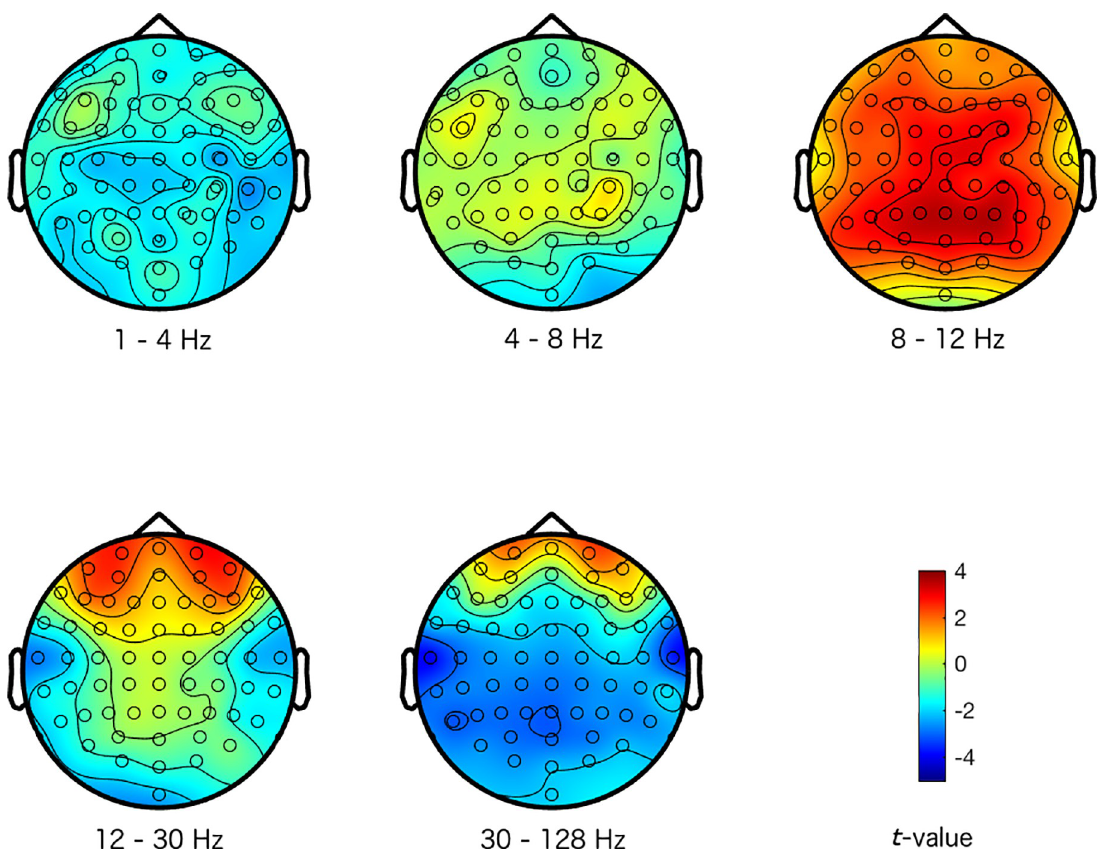
Fig 2. Maps of the difference between a sad response and the other emotional responses. The colors represent t -values. The different scalp maps show the contrast (expressed in t -values) between activity representing a sad response, and activity representing the other emotional responses for the specific frequencies that are indicated below the maps (the delta (1–4 Hz), theta (4–8 Hz), alpha (8–12 Hz), beta (12–30 Hz), and gamma (30–128 Hz) frequency range respectively), and across the head for the 64 electrodes.